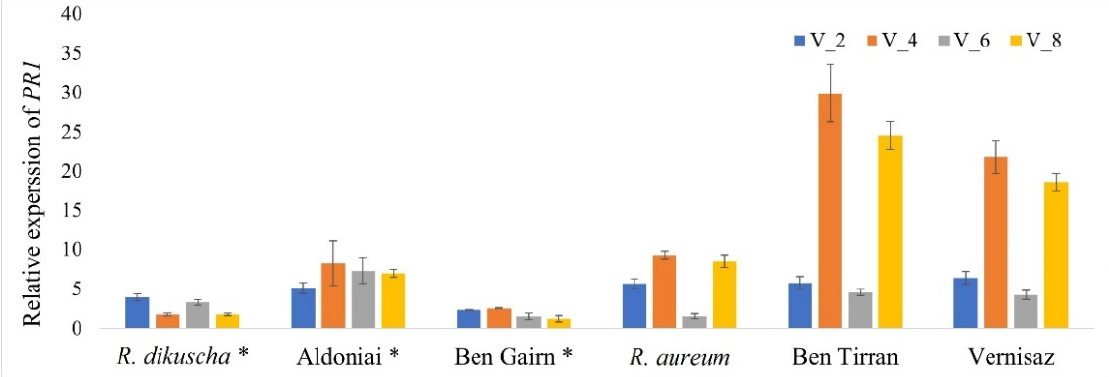
Figure 7. Relative expression levels of PR1 in resistant and susceptible Ribes genotypes in response to BRV infection. The expression of each sample was calculated from the control mock ‐ inoculated plant at points 2, 4, 6, and 8 dpi; *—BRV ‐ resistant genotypes.